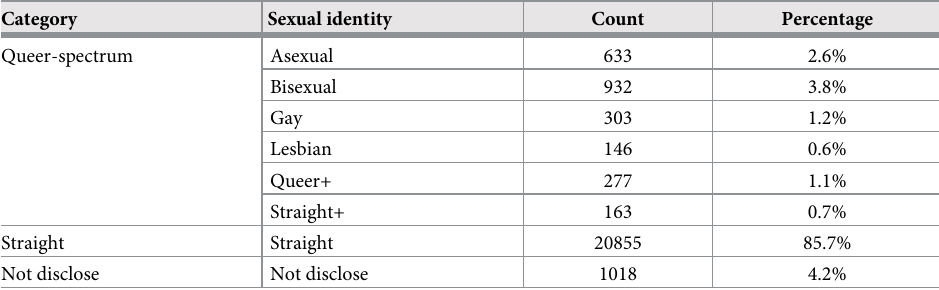
Table 3. Sexual Identity categories with response counts and